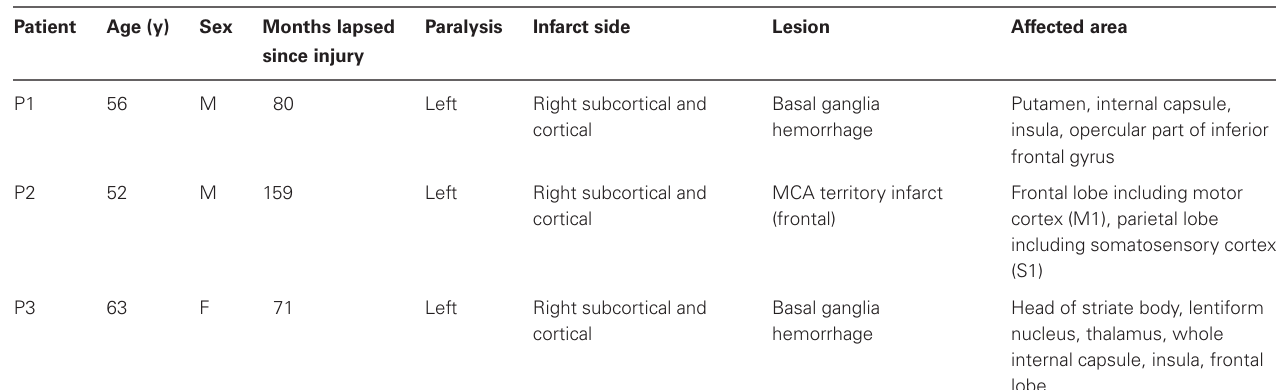
Table 1 | Patient